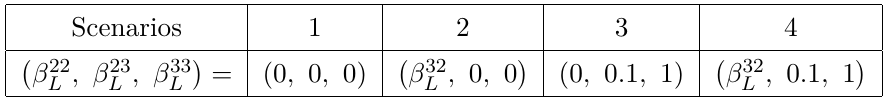
Table 1 . Different flavor structure scenarios we consider in this work. The LQ mass m LQ and its Yukawa coupling to b ¯ µ ( β 32 ) are treated as free parameters in our study. We fix the other couplings L to the values indicated in this table to study the effect of the β L -matrix flavor